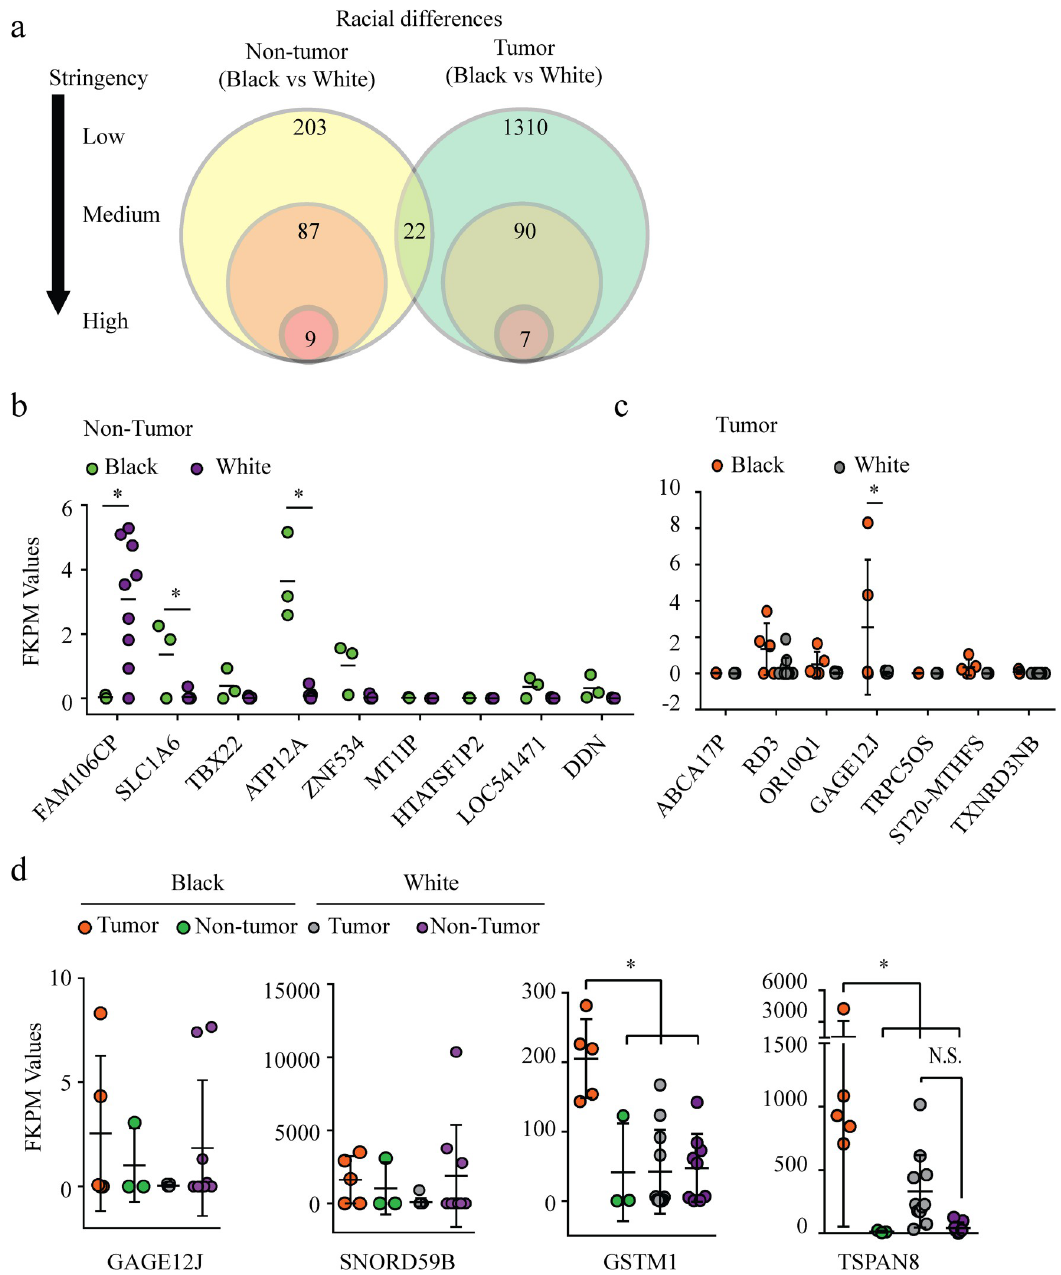
Fig 3. Characterization of genes expression differences between non-tumor and tumor pancreatic tissue from Black and White patients. (a) Venn diagram of the number of significant gene differences that meet the low, medium, and high stringency criteria using racially categorized non-tumor and tumor tissue. (b & c) Individual gene expression levels that met the high stringency criterion from different tissue types and racial backgrounds using non-tumor (b) and tumor tissue (c). A two-tailed ANOVA with tissue type and gene as factors with a Tukey’s post hoc test was leveraged to identify gene and tissue type interactions. (d) GAGE12J , SNORD59B , GSTM1 , and TSPAN8 expression levels in human pancreatic tumor and non-tumor tissue from Black and White patients. One way ANOVA was performed for each gene. � indicates a p < 0.05.